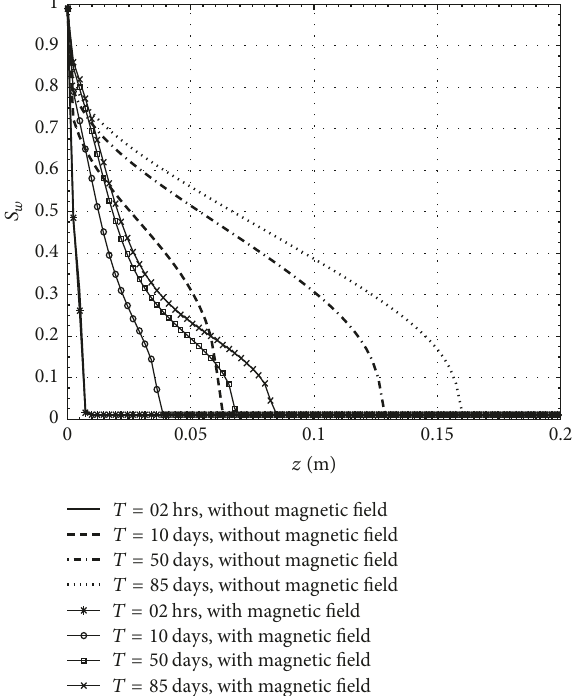
Figure 10: Saturations profiles against the core length with and without magnetic field effect for various values of imbibition time: magnet is placed on the left side of the